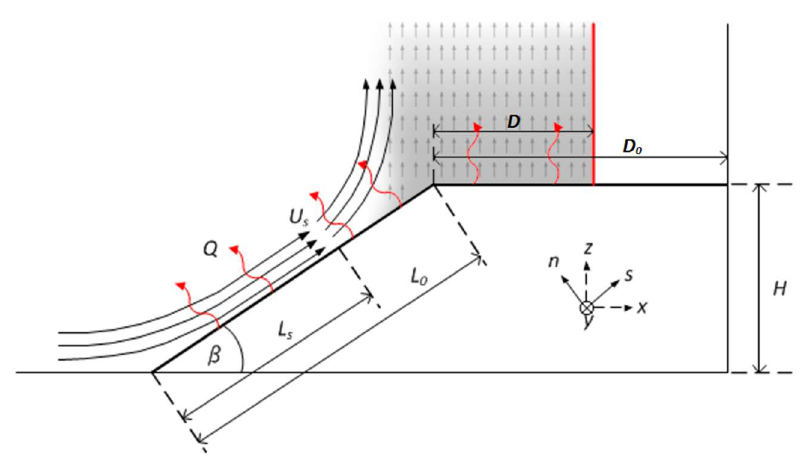
Figure 1. A schematic of the experimental configuration. The width of the plateau (𝐷) was varied by moving the vertical wall indicated in red.